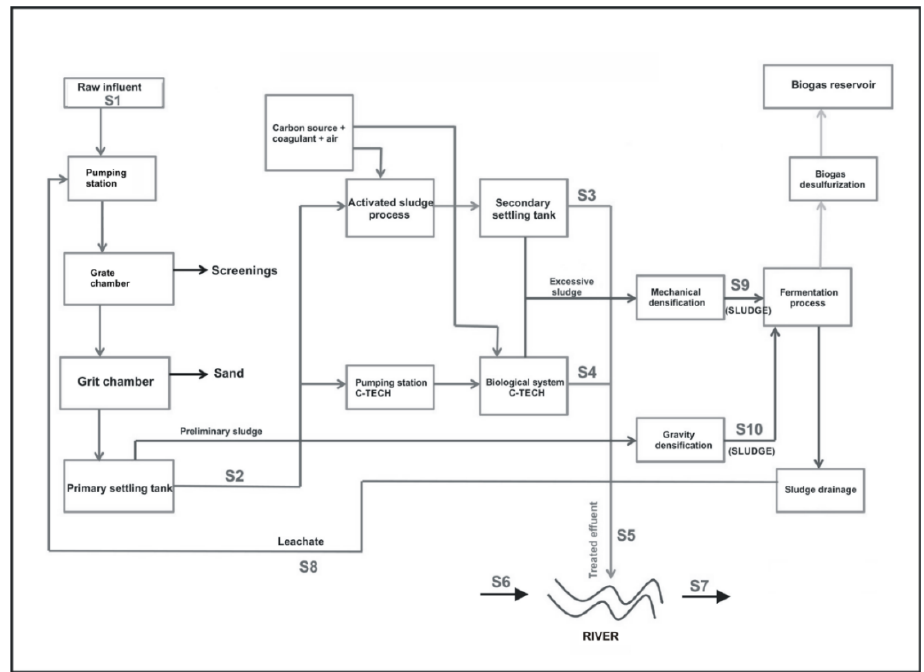
Figure 1. Scheme of wastewater treatment plant with sampling point.